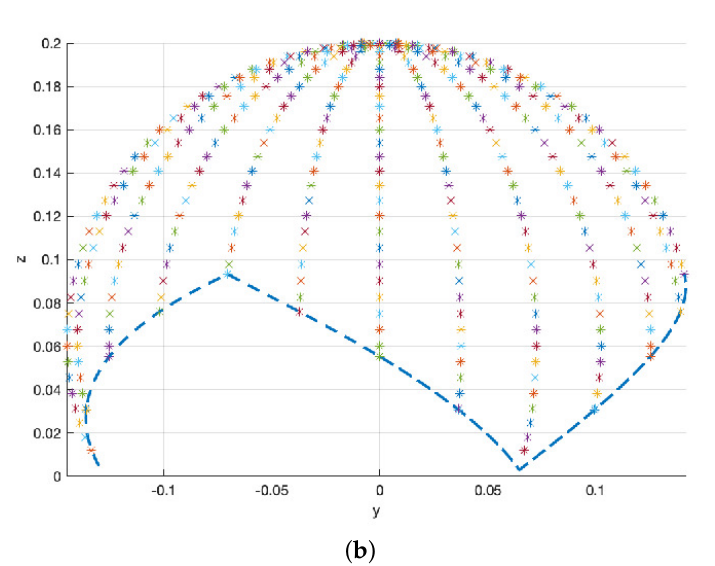
Figure 13. Diagram of soft joint end positions, represented by ‘ ∗ ’ marks, at different orientation planes, every 15 degrees, and for every 5 inclination degrees. The dashed line indicates the flexion limits of the soft joint for each orientation. The soft joint cannot reach further positions due to blockages. ( a ) Front view. ( b ) Side view.